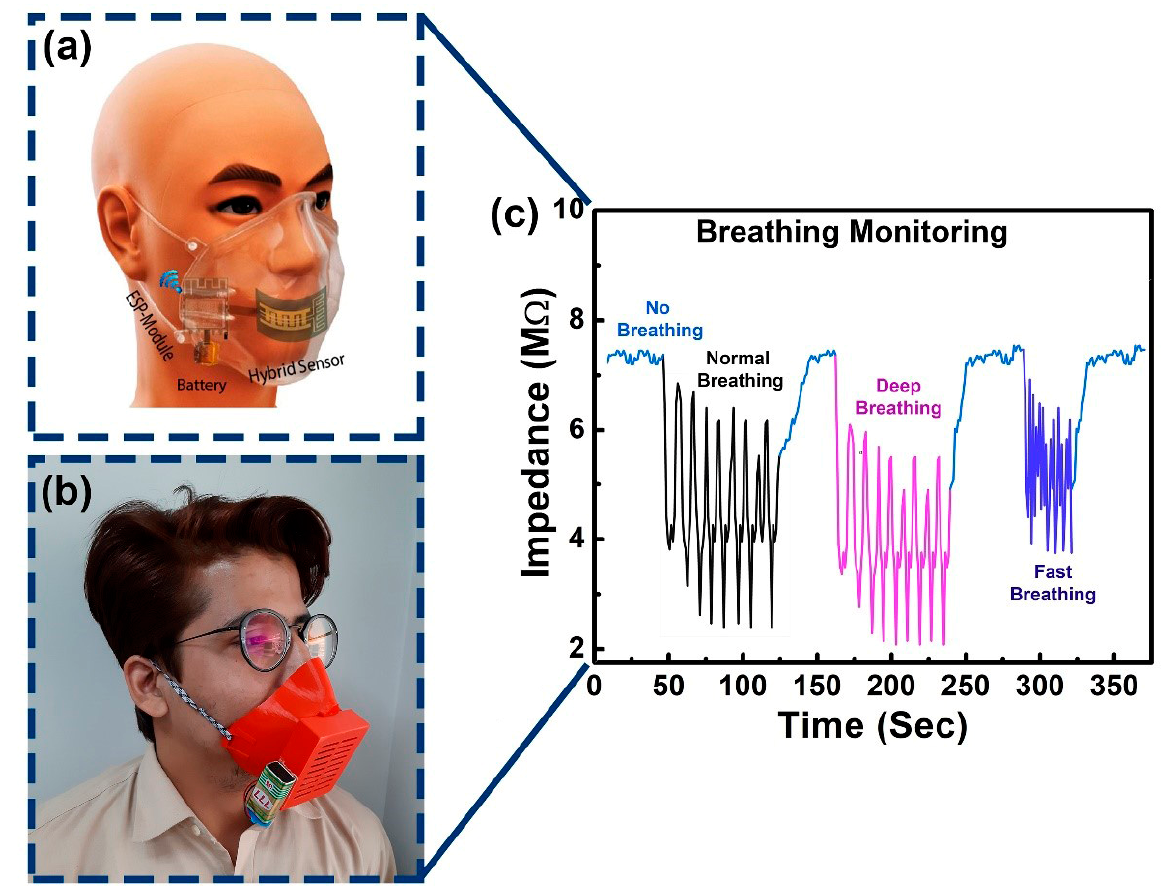
Figure 9. Implementation of the fabricated hybrid flexible sensor for a wearable human health-monitoring application. ( a ) shows the proposed prototype, ( b ) shows the subject wearing the as-developed gear, ( c ) shows the response of breathing.